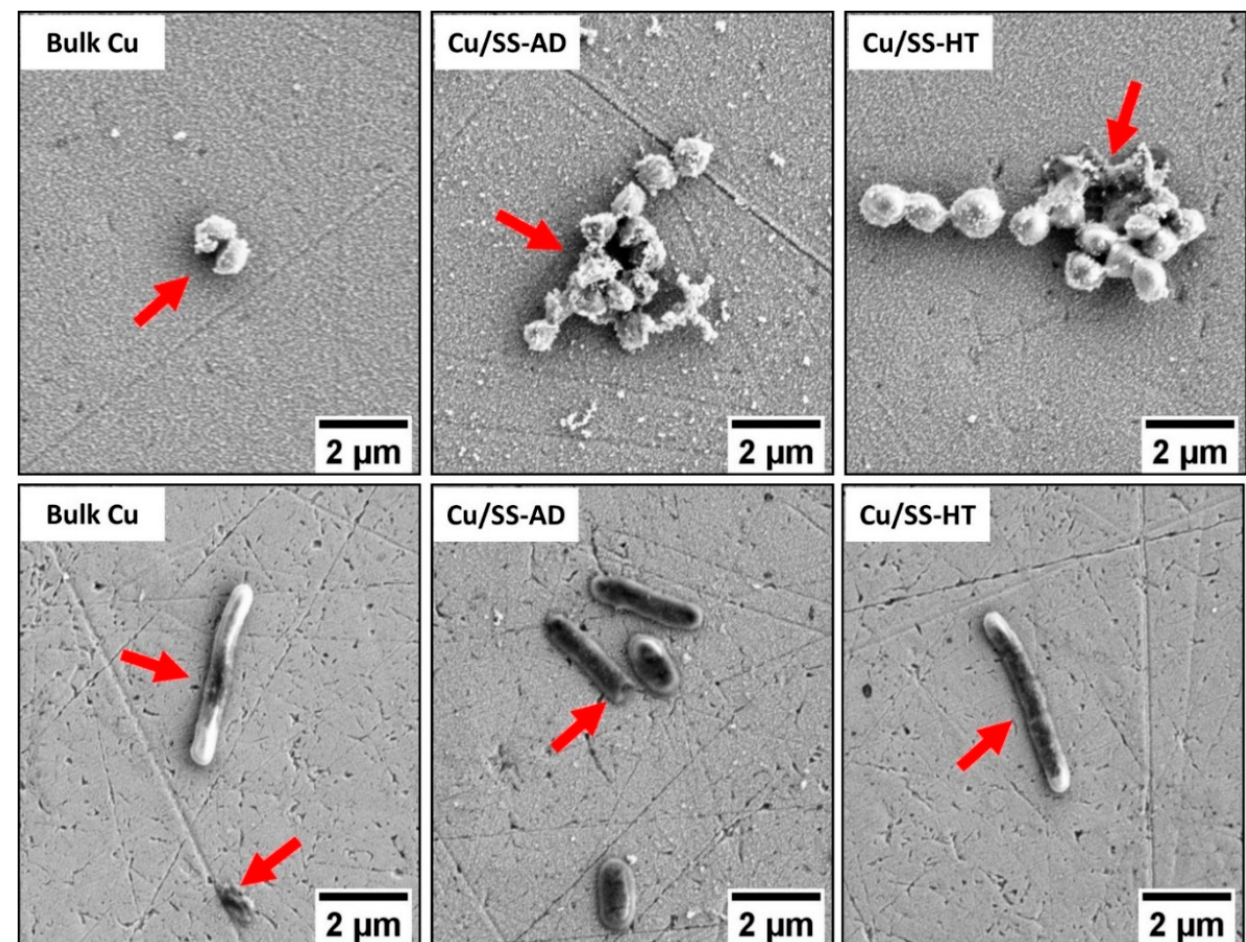
Figure 6. SEM images showing the morphology of bacterial cells S. aureus ( top row ) and E. coli ( bottom row ) attached to the different Cu samples tested after 15 min exposure. Red arrows are pointing towards abnormal bacterial cell shape/feature and/or disrupted cell walls.